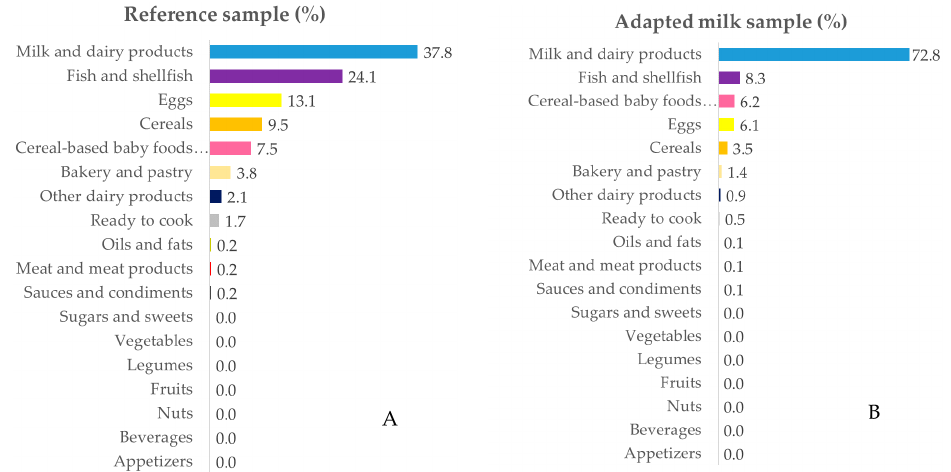
Figure 4. Percentage of the 18 food groups sources, in terms of the total vitamin D intake (%), among the reference sample ( A ) and the adapted milk consumer sample ( B ) of the Spanish Pediatric Population (EsNuPI) study.